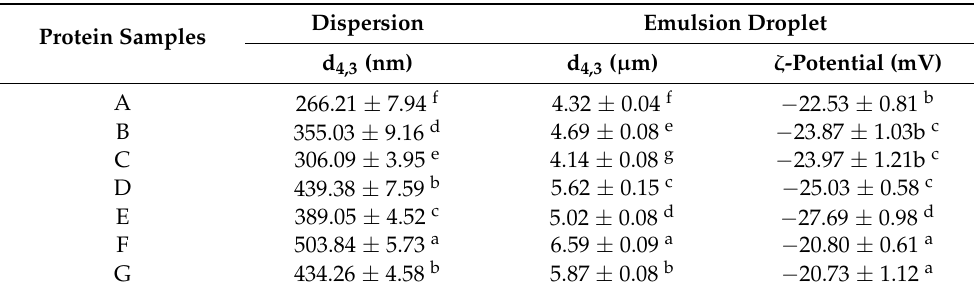
Table 3. The d 4,3 of the oxidized SPI dispersion and the d 4,3 and ζ -potential of the emulsion droplets before and after the cavitation jet